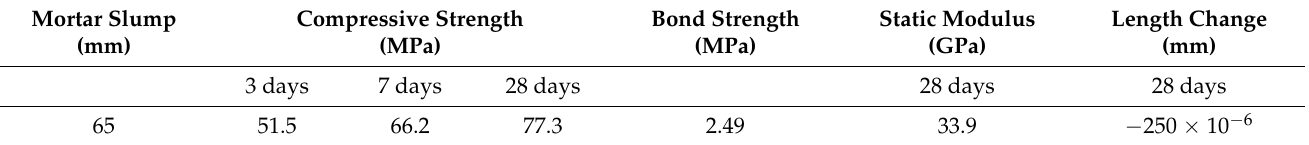
Table 1. Mechanical properties of polymer-based mortar without fibers [28].